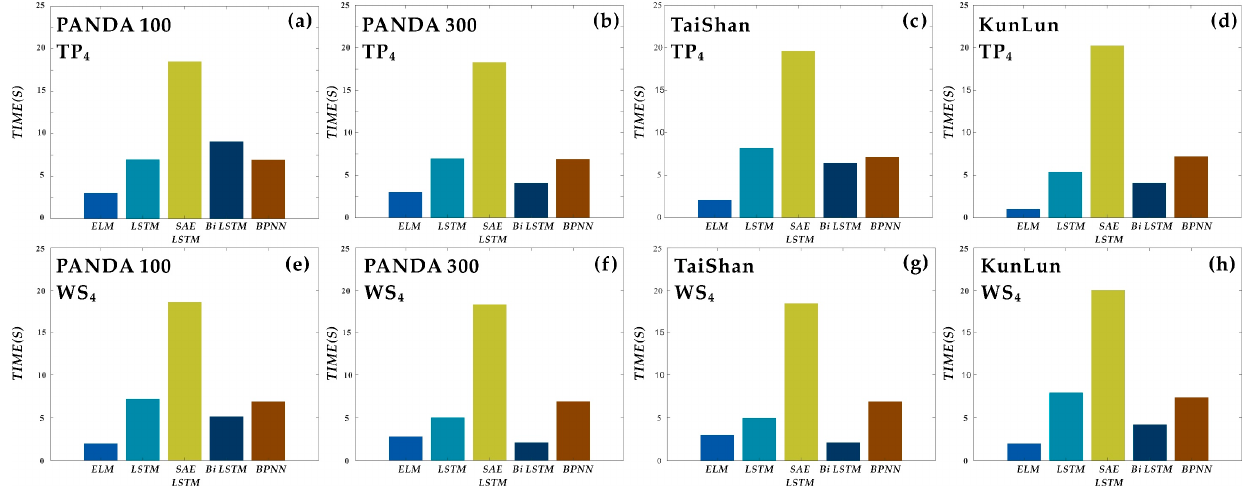
Figure 13. Single-step prediction experiment 4 m temperature versus wind speed at four sites: ( a – d ) are comparisons of individual model times for single-step prediction of 4 m temperature at four locations; ( e – h ) are comparisons of personal model times for single-step prediction of 4 m wind speed at four sites.